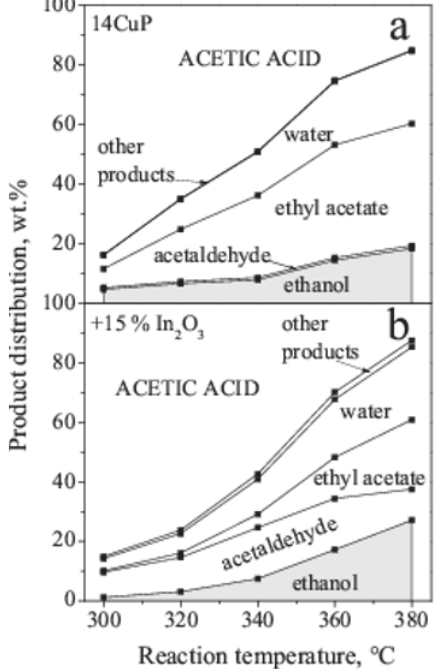
Figure 5. Product distributions of 14CuP (a) and 15In catalysts in the conversion of AA as function of reaction temperature at 21 bar. The partial pressures of AA and H were 2.1 and 18.9 bar. The WHSV of AA was 3 h -1 .